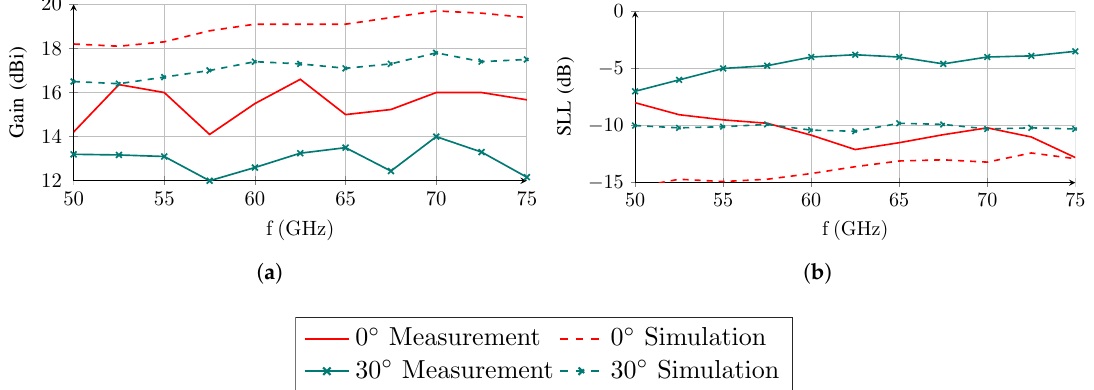
Figure 45. Comparison of simulated and measured ( a ) gain and ( b ) SLL behavior for θ beam = 0° and θ beam =